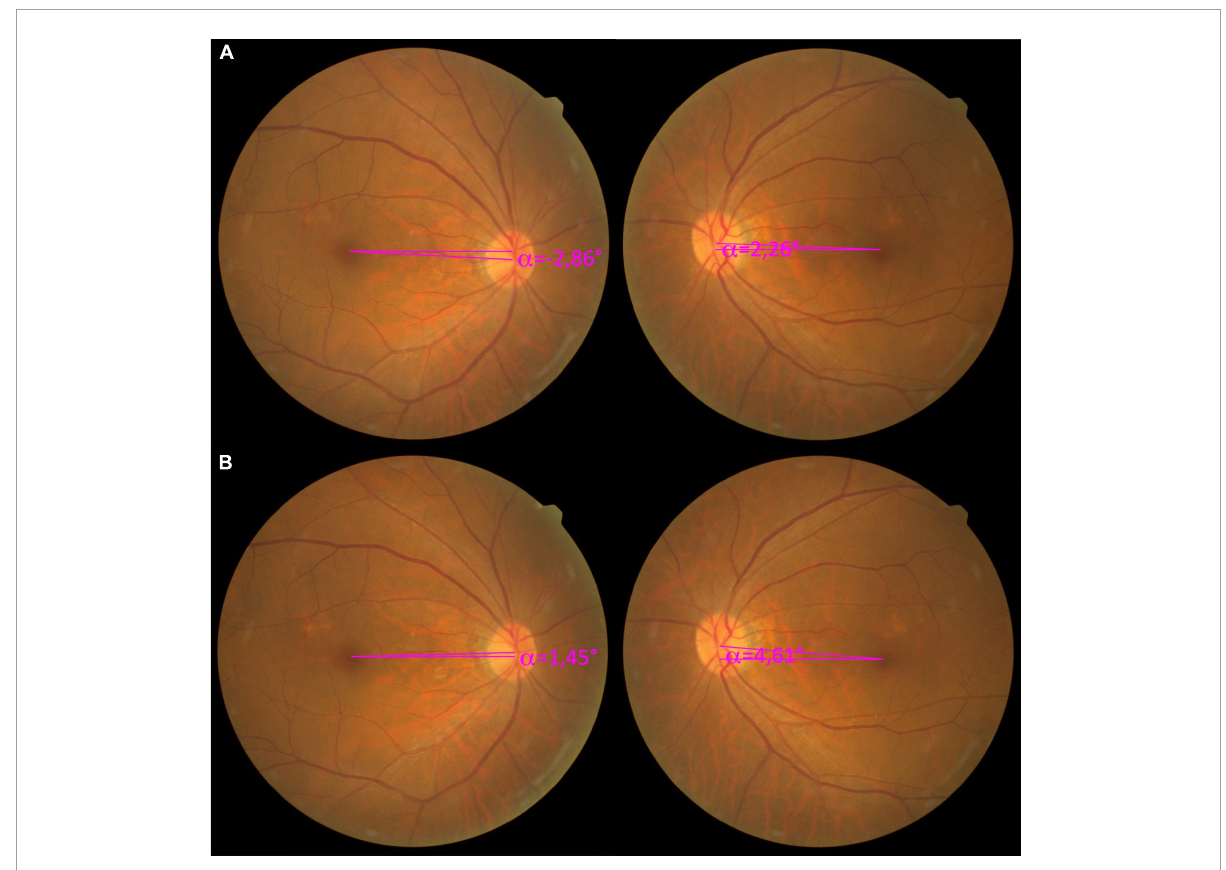
FIGURE3 Pre- and postoperative color fundus photography of Patient 9, with a right superior rectus muscle hypertrophy due to idiopathic orbital inflammation. (A) The preoperative color fundus photograph showed a relatively small disc-fovea angle (DFA) in both eyes with an easily missed incyclotorsion of the right eye, with a − 2.86 ◦ DFA, and a 2.26 ◦ DFA in the left eye. However, the subjective net incyclotorsion was 8 ◦ measured by the double Maddox rod (DMR) test. (B) The 3-month follow-up fundus photograph showed a net reduction of 4.31 ◦ excyclotorsional effect from the superior rectus recession, with the right DFA being 1.45 ◦ and the left DFA 4.61 ◦